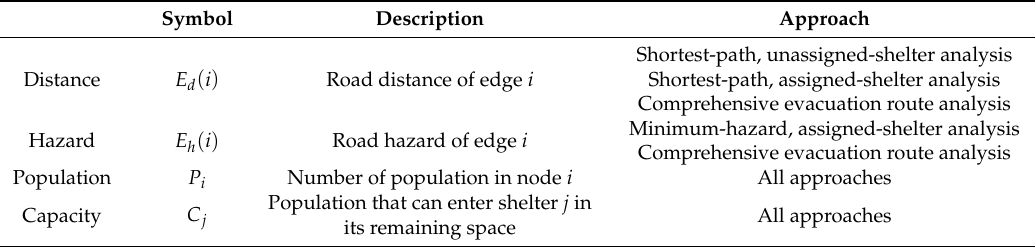
Table 2. Key variables for evacuation route analysis.